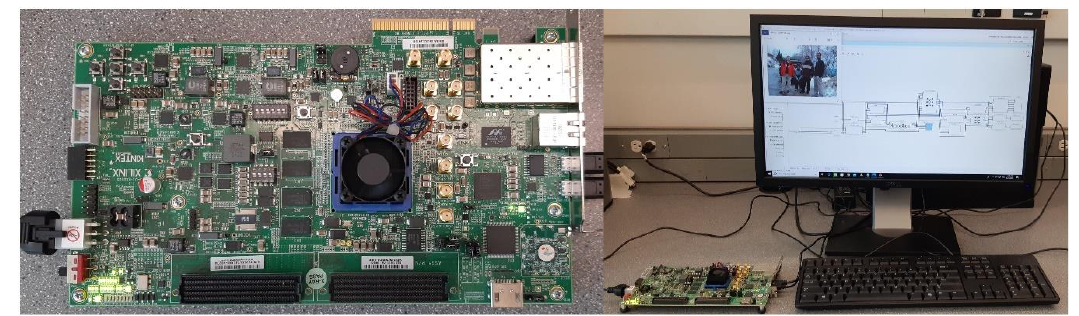
Figure 1. The KCU105 FPGA board ( left ) connected to the computer station ( right ) for experiments.